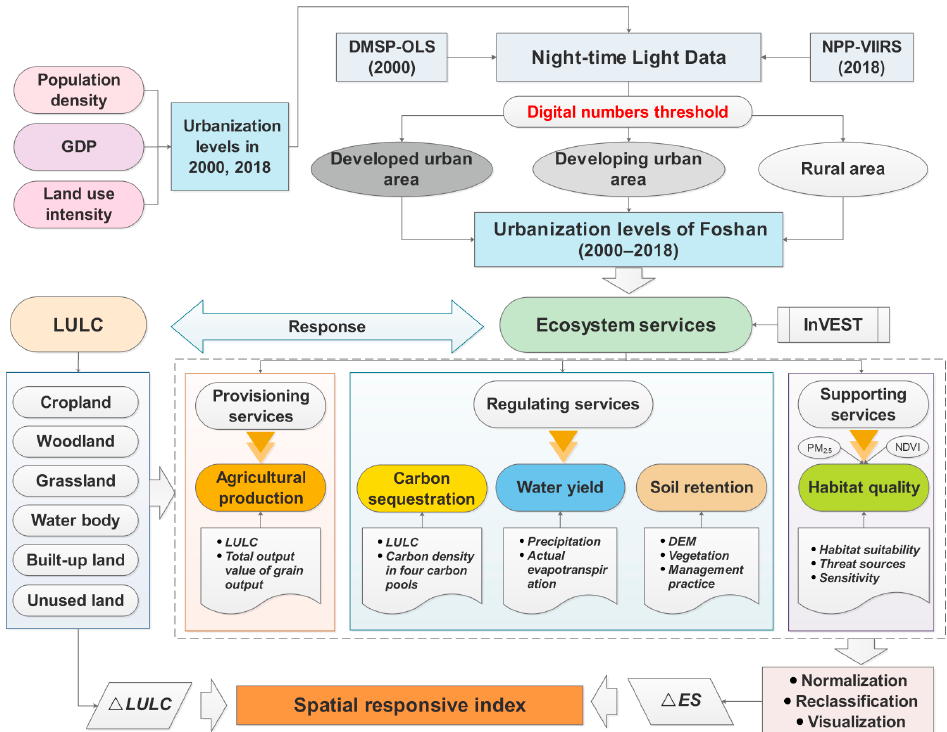
Figure 2. Method framework linking nighttime light data, land use and land cover change (LULC), and ecosystem services (ES).